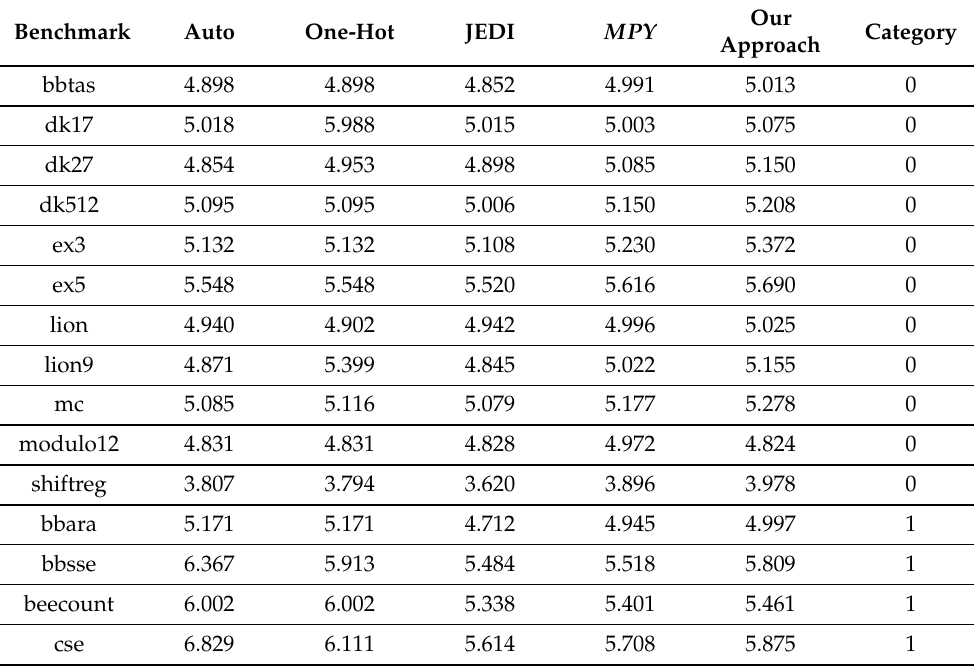
Table 9. Experimental results (the latency time for all benchmarks,